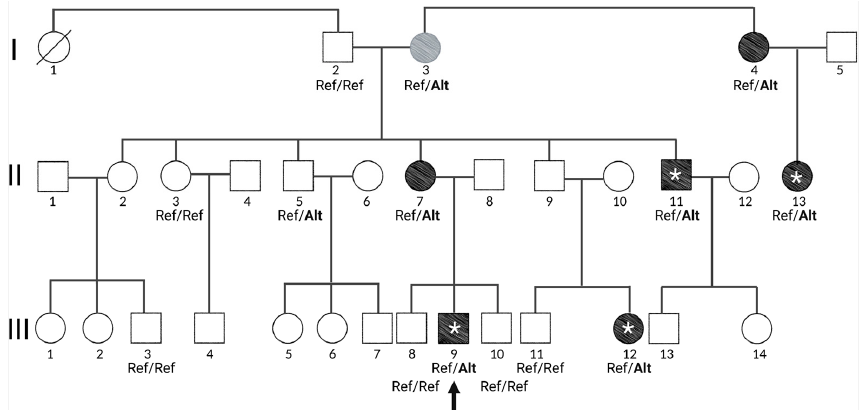
Figure 1. Three-generation family presenting with autosomal dominant inheritance of psychosis. Generations are marked in Latin numerals, I, II, III. Proband is marked with an arrow. Females are circles and males are squares. Individuals with a diagnosis of psychosis are shaded with black and individual I-3 who has anxiety disorder is shaded in gray. Exome sequencing was performed on individuals that are marked with an asterisk (*). Genotypes of the CASKIN1 variant for all individuals where DNA was available are indicated under the individual’s number where Ref = reference allele and Alt = alternative allele. Only individuals with a genotype were clinically examined.